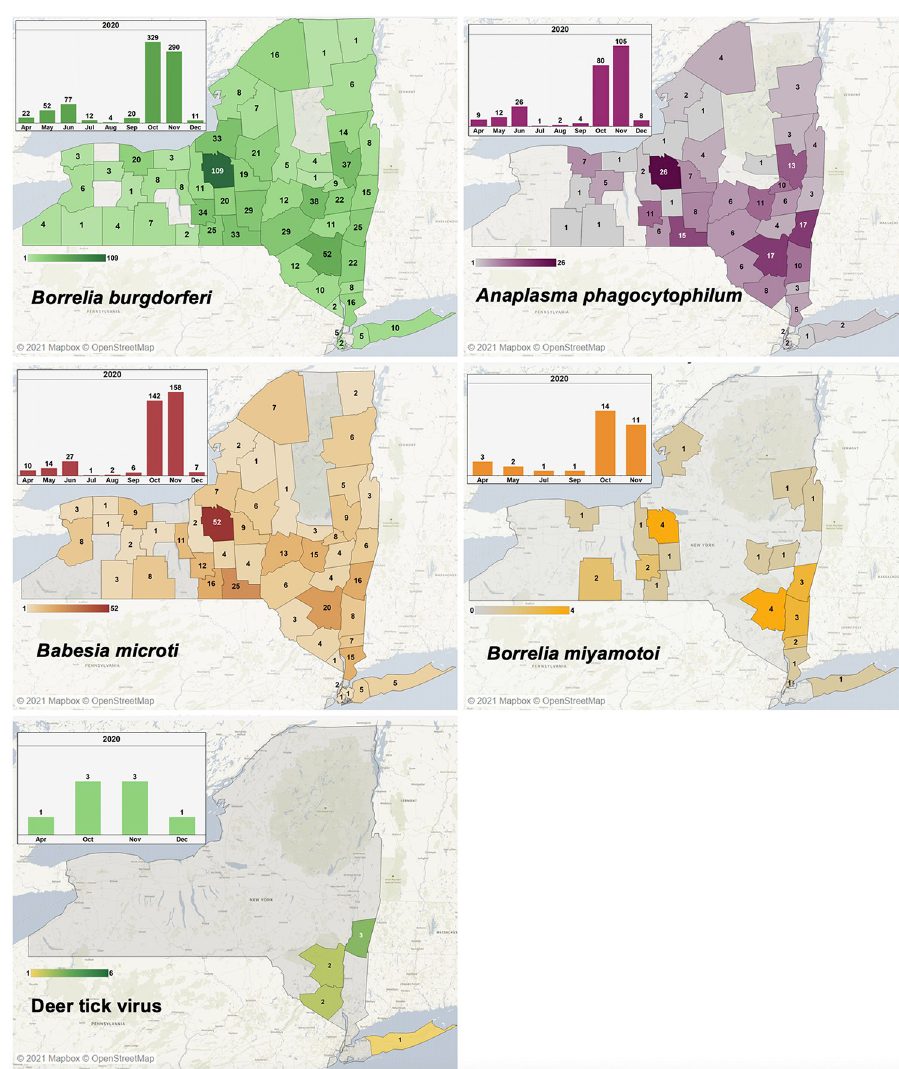
Fig 4. Prevalence of tick pathogens by county level and the seasonal distribution of the pathogens (inset). In New York, the most common pathogen in I . scapularis is B . burgdorferi , followed by B . microti and A . phagocytophilum , with statewide distribution. Borrelia miyamotoi is rarer but has a wide distribution across the state, while DTV, the least common pathogen observed, was restricted to the southern portion of the state and most prevalent in the Hudson Valley region. The base map for the images was obtained from Mapbox which is an open source map available at http://www.studio.mapbox.com.